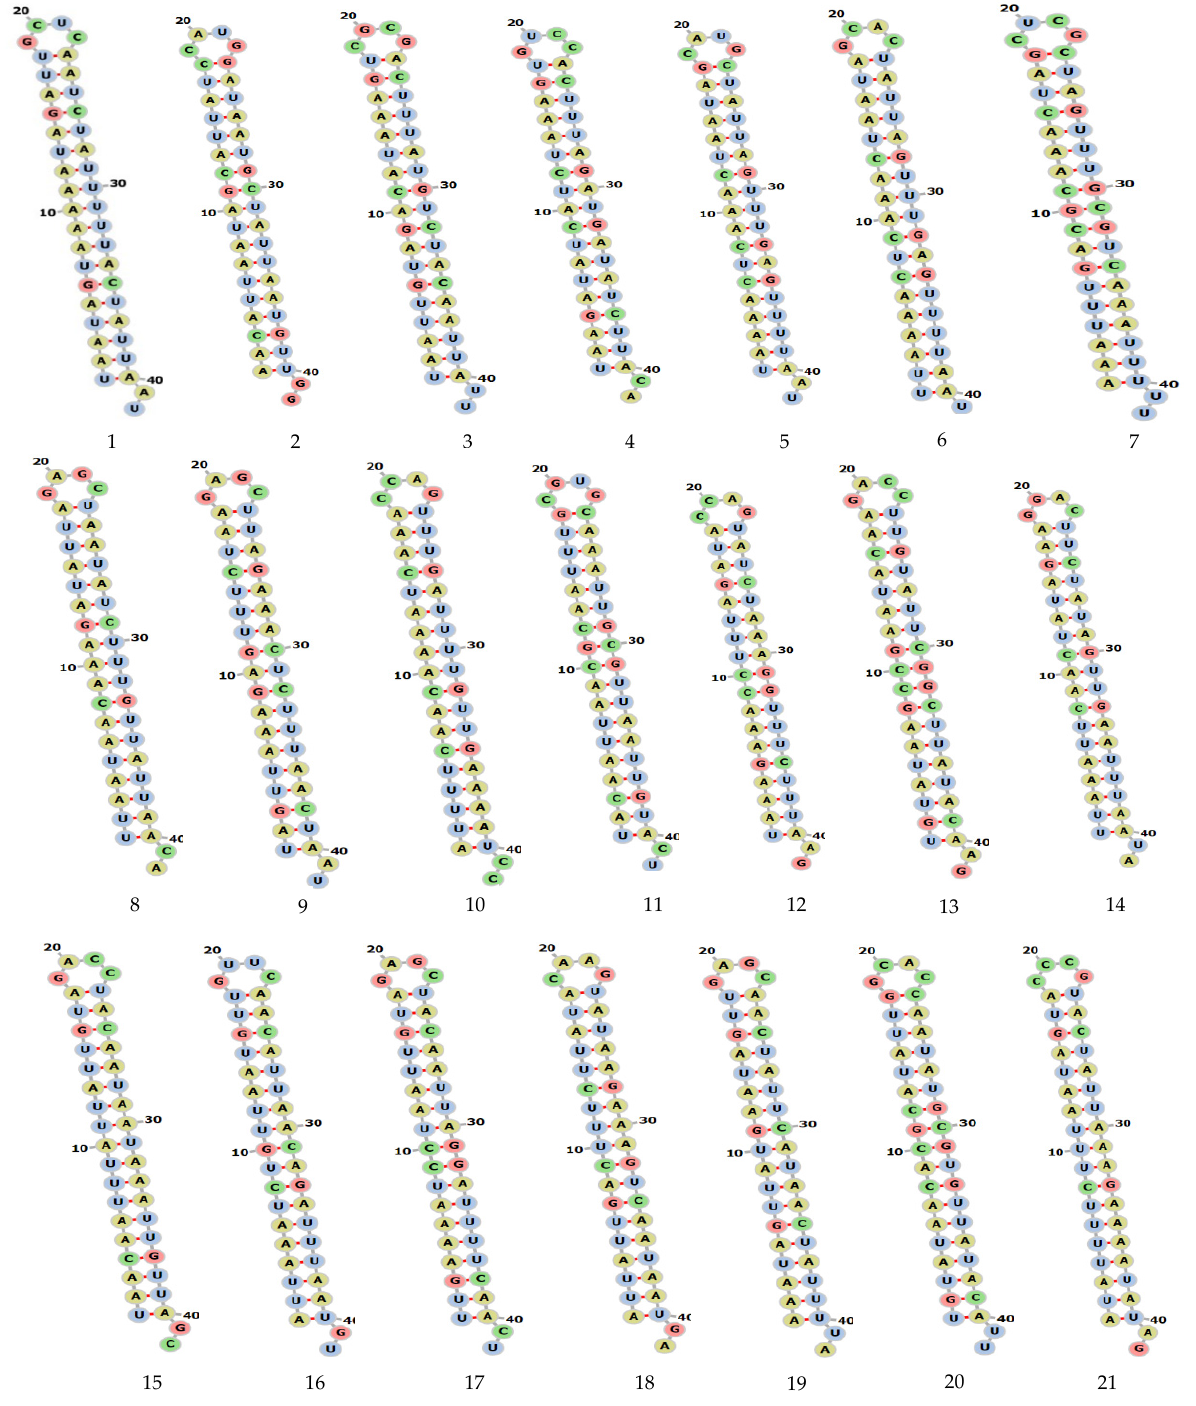
Figure 2. Secondary structure of siRNA MERS-CoV genome predicted by using RNAfold software and were visualized in forna Figure 3. The proposed centroid secondary structure of the MERS-CoV-ORF1ab gene with nucleotide positions was predicted using RNAfold software and downloaded in PNG format. The phosphodiester backbone is shown in orange color and the nucleotides are shown in the sticks and filled rings with elemental coloring; Green, red, yellow and blue. The color of the secondary structure indicates; green: C (canonical helices), red: G (junctions), yellow: A, blue: U hairpin loops. The structure shows all the nucleotides and their bindings with each other and forming stem, hairpin loops, canonical helices, and junctions. Chemically modified nucleotides are unpaired, in A-U or G-C pairs at helix ends, in G-U pairs anywhere, or adjacent to G-U pairs.